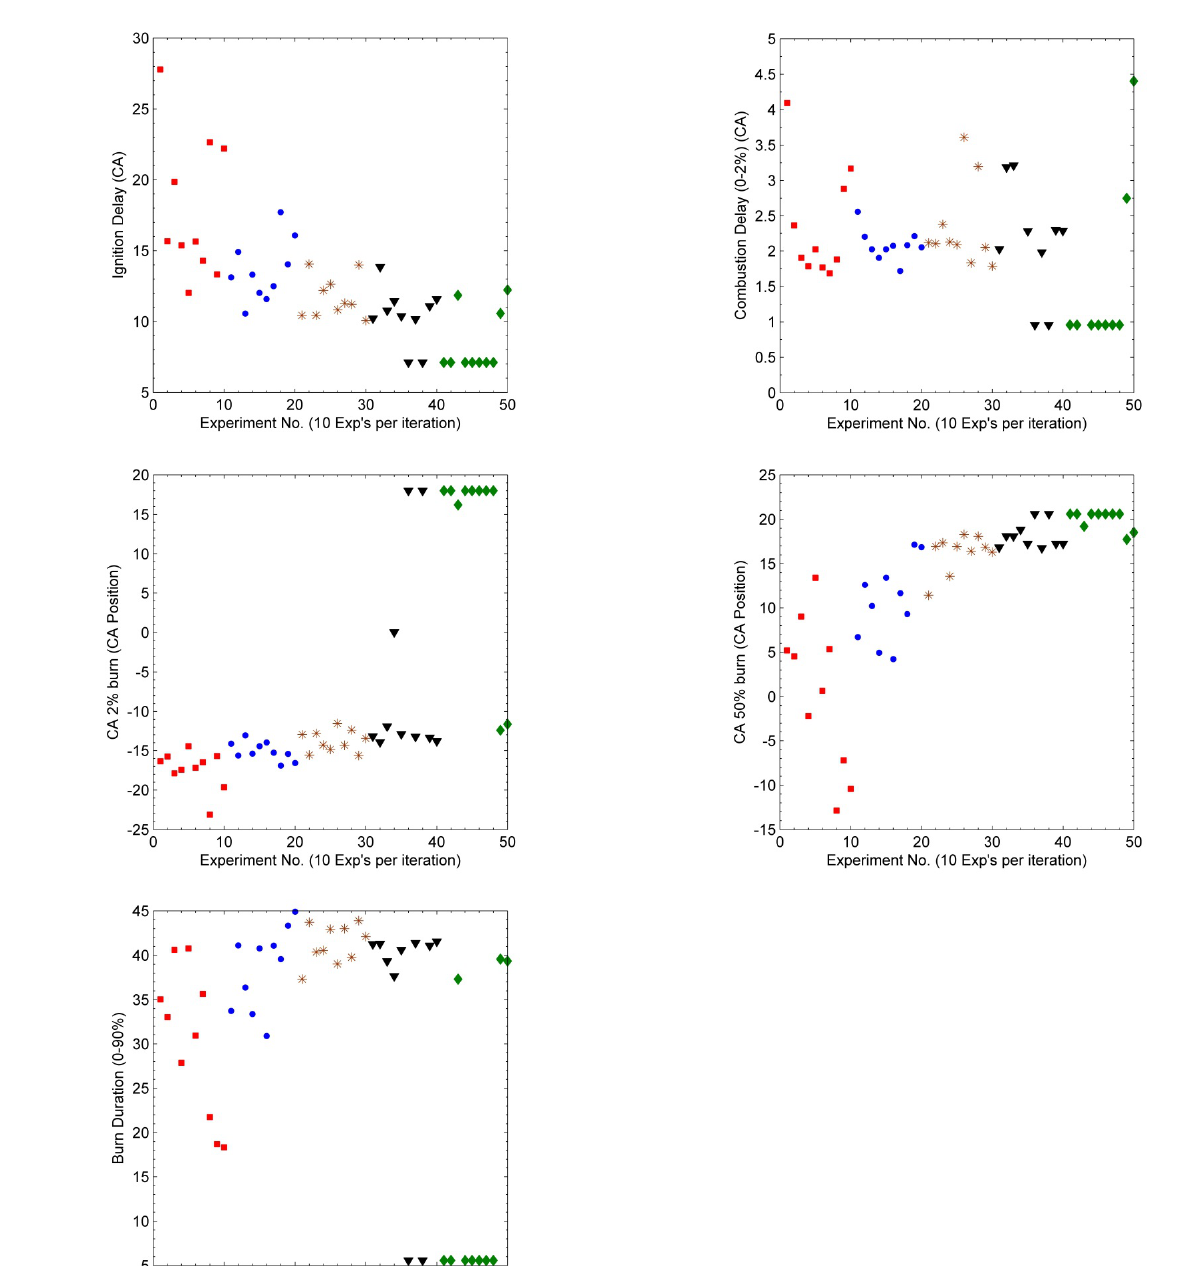
Various combustion parameters for the runs during optimization are shown in Figure 10. The results show that a small ignition delay is preferred towards meeting the op- timization targets. Smaller ignition delay avoids the NOx formation while not significantly affecting the BSFC. This was accomplished by shifting the main SOI towards the right extreme of 10 ATDC. As a result the CA 50%